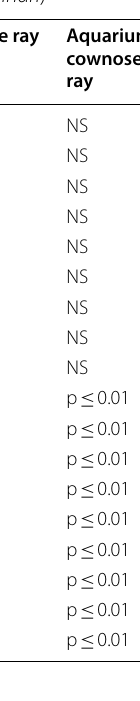
Table 6 Pairwise results for all permutational multivariate analysis of variance (PERMANOVA) for all β‑diversity metrics between different body sites for cownose ( Rhinoptera bonasus ) and wild and aquarium whitespotted eagle rays ( Aetobatus narinari )